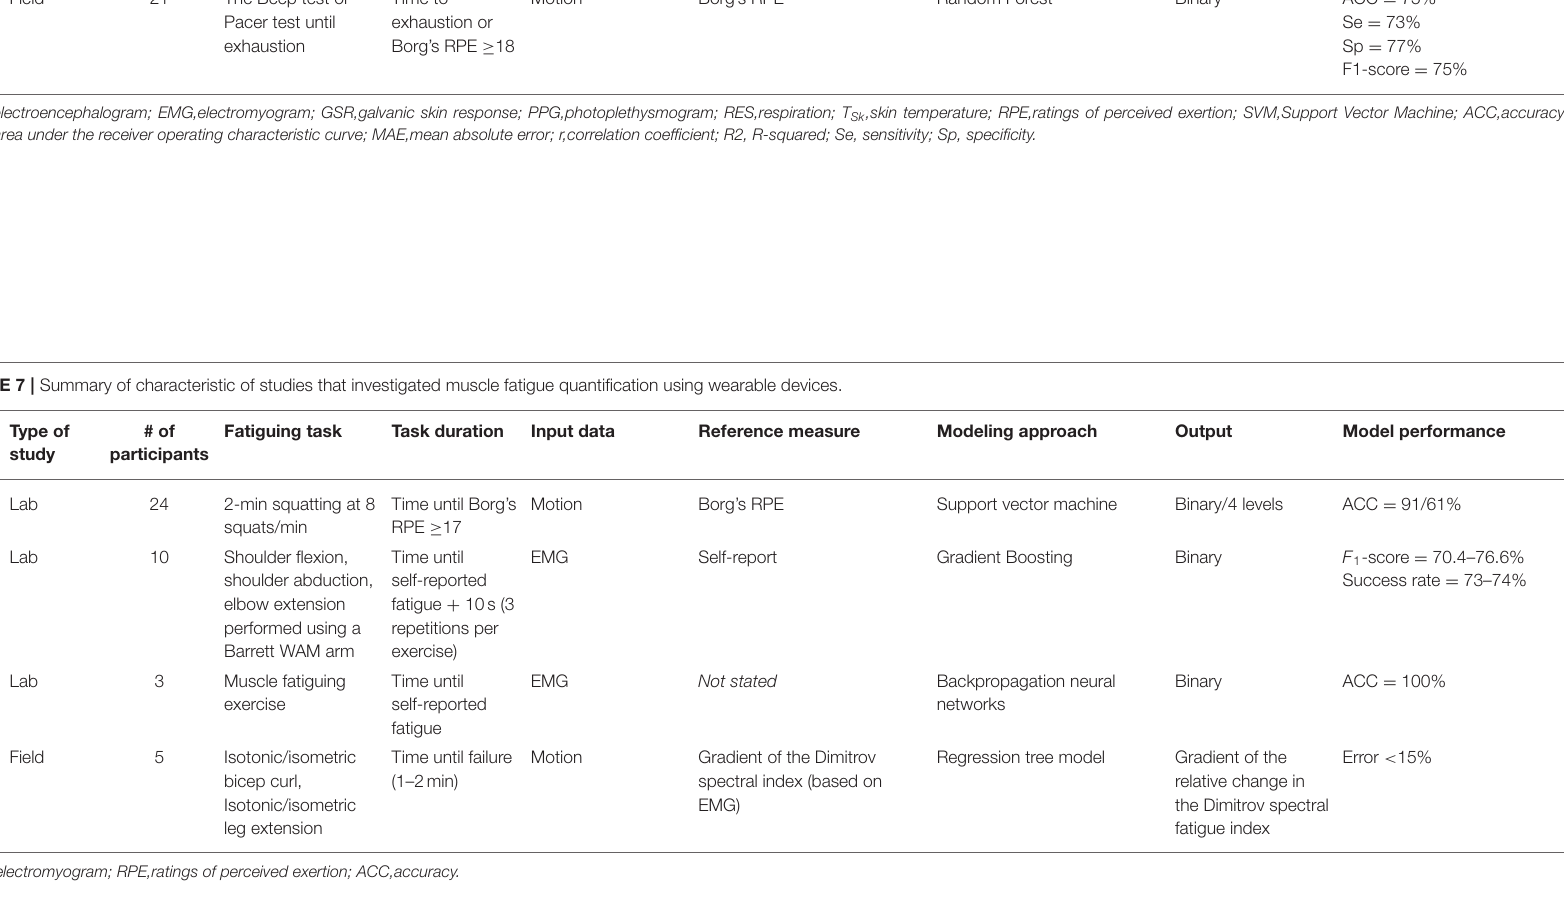
EMG,electromyogram; RPE,ratings of perceived exertion;